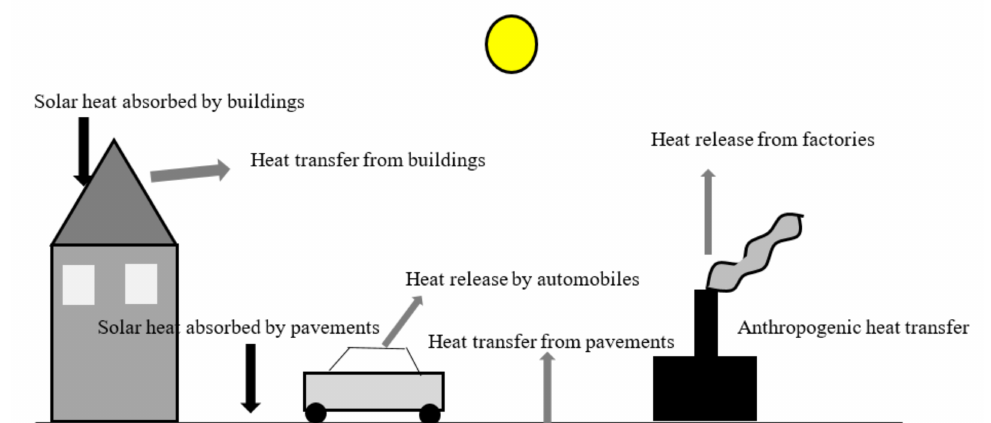
Figure 1. The urban heat island (UHI) effect in